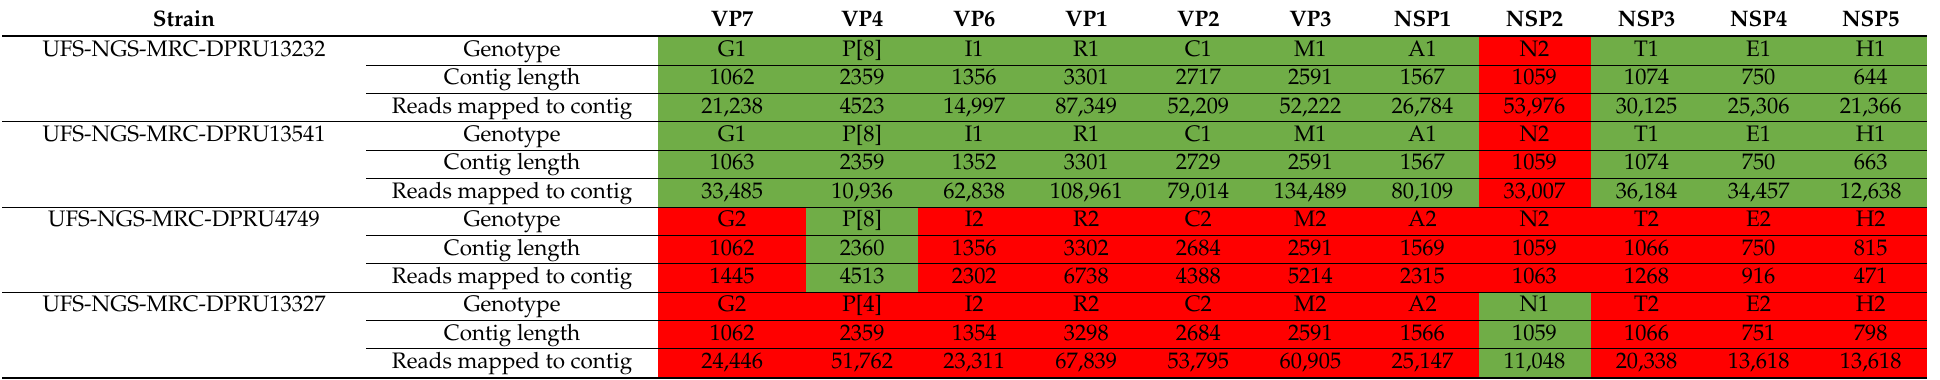
Table 2. The whole genome constellation of the four reassortant study strains detected between 2014 and 2016 (post-vaccine period) in Zambia along with the contig length and the number of reads mapped to each